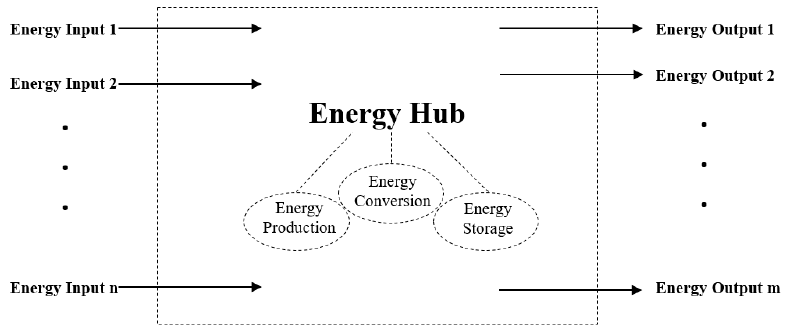
Figure 1. An illustrative energy hub.